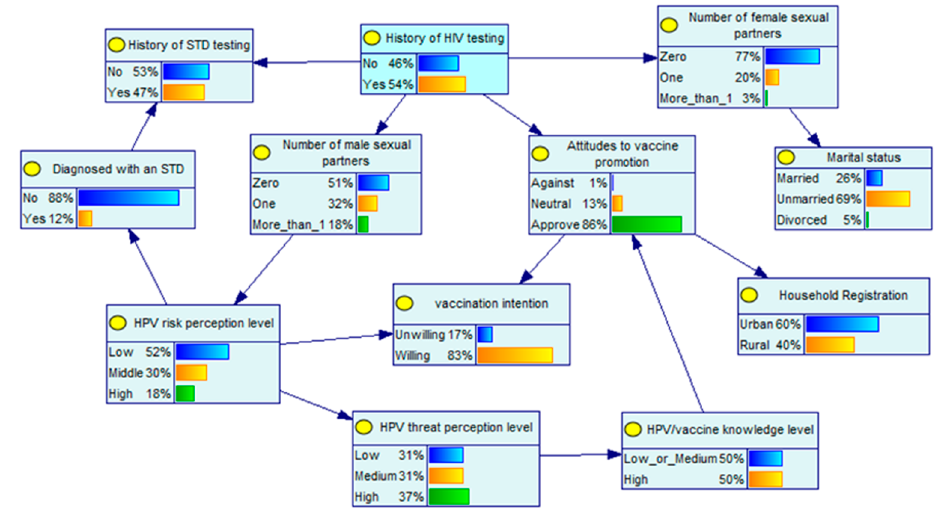
Figure 1. Bayesian network simulation diagram.